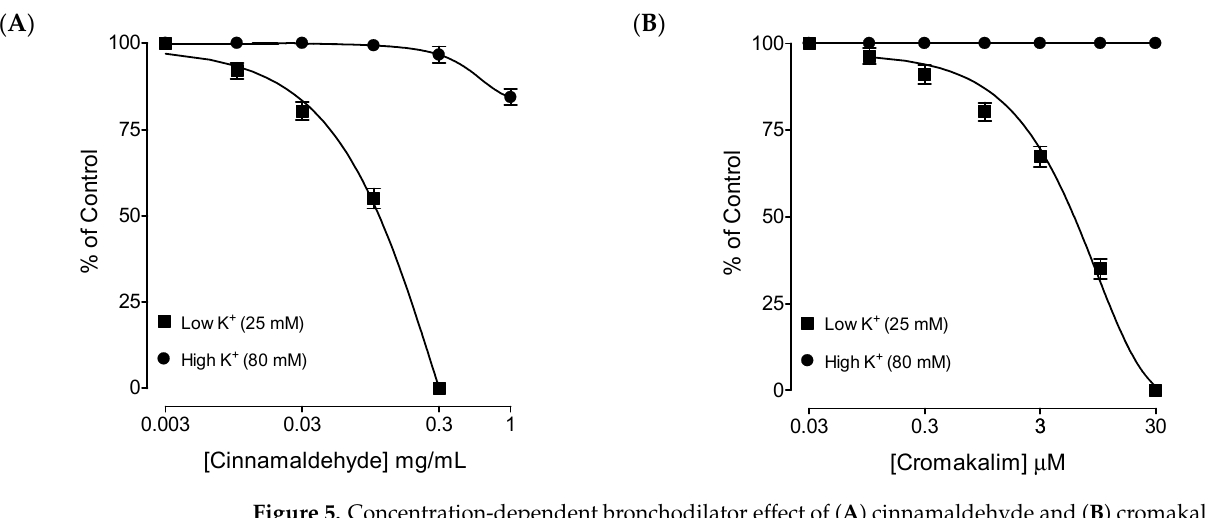
Figure 5. Concentration-dependent bronchodilator effect of ( A ) cinnamaldehyde and ( B ) cromakalim, against low K + (25 mM) and high K + (80 mM)-induced bronchoconstriction using isolated guinea pig tracheal strip preparations. Results are expressed as mean ± SEM, n = 4.